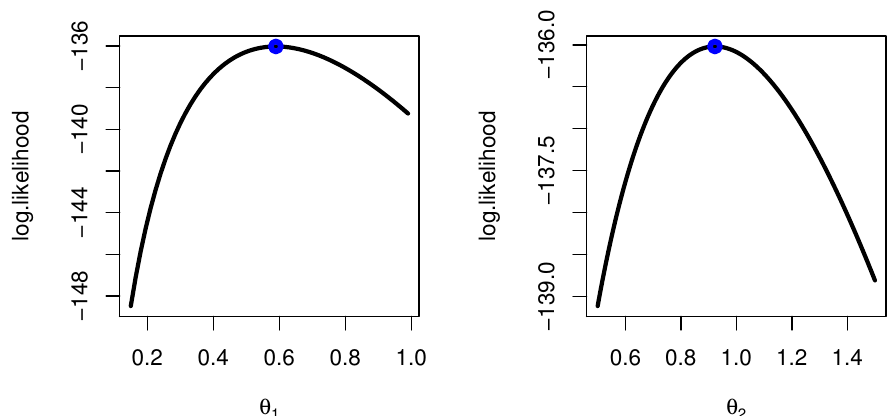
Figure 3. Profile likelihood for parameter estimation by SRS method for banking data.